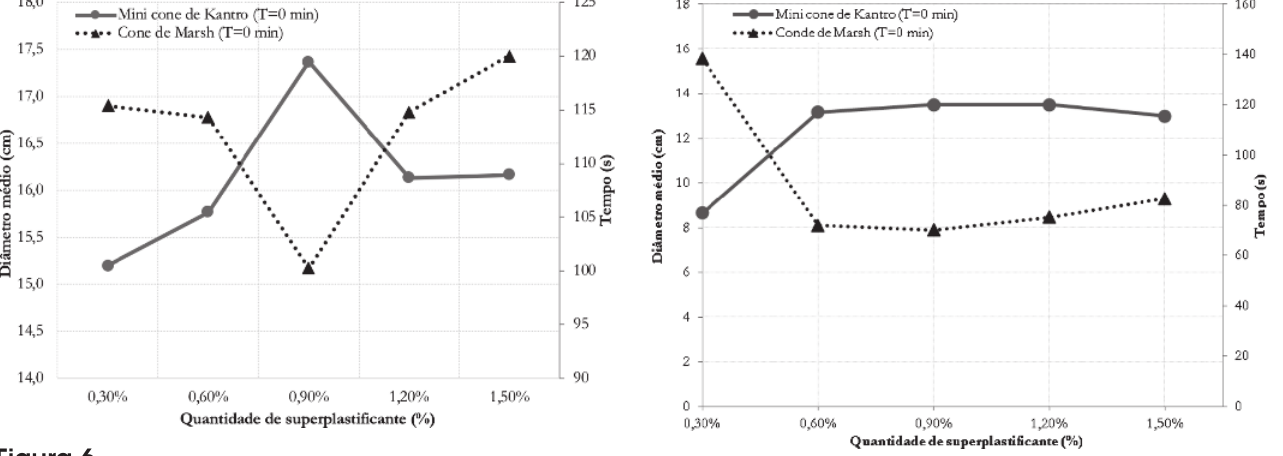
Resultados da compatibilidade cimento e SP no mini cone de Kantro e no cone de Marsh